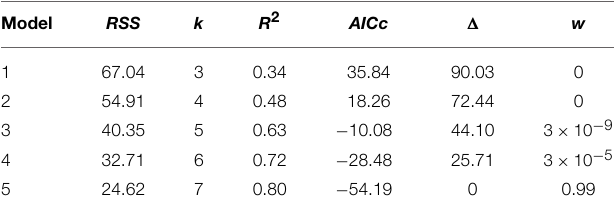
TABLE 8 | Summary of the Opinion shift best model.